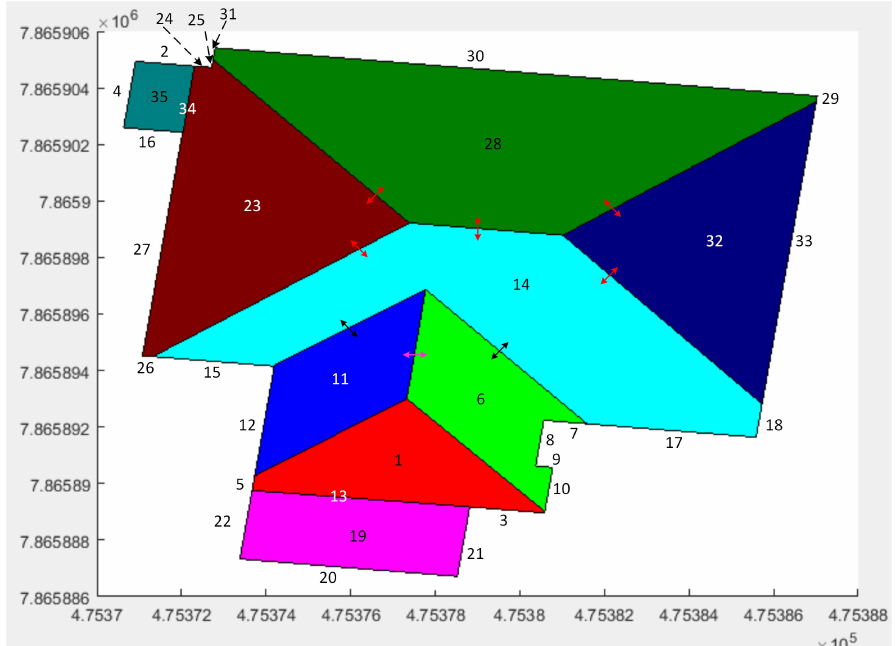
Figure 11. Relationship between the connected building planes; black, red, and magenta arrows represent the parent-to-child, parent-to-parent, and child-to-child connections, respectively. This building is the one within the orange rectangle in Figure 10a and its wall plane numbers are shown outside the building